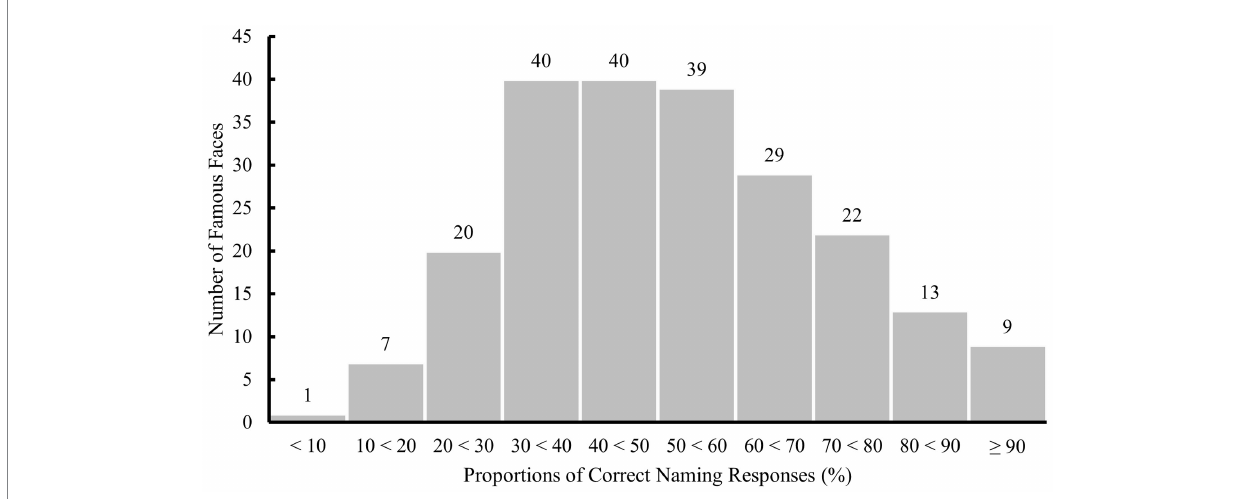
FIGURE 6 Distribution of proportions of correct naming responses to all 220 famous faces included in step 4. Labels on top of each bar indicate the number of famous faces per